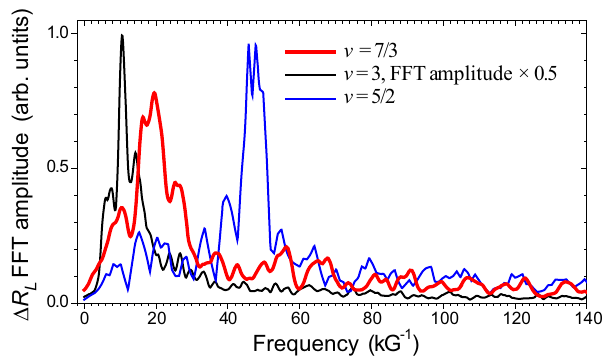
FIG. 6. Absence of significant high-frequency spectral features in the oscillations at ν ¼ 7 = 3 (red) in the same sample, prepa- ration, and magnetic field trace where a marked peak in the vicinity of 5 f 0 is observed at ν ¼ 5 = 2 (blue). The FFT of oscillations at ν ¼ 3 in the same sample is shown in black for comparison; it establishes the fundamental frequency f 0 (sample 6, preparation 36, T ∼ 25